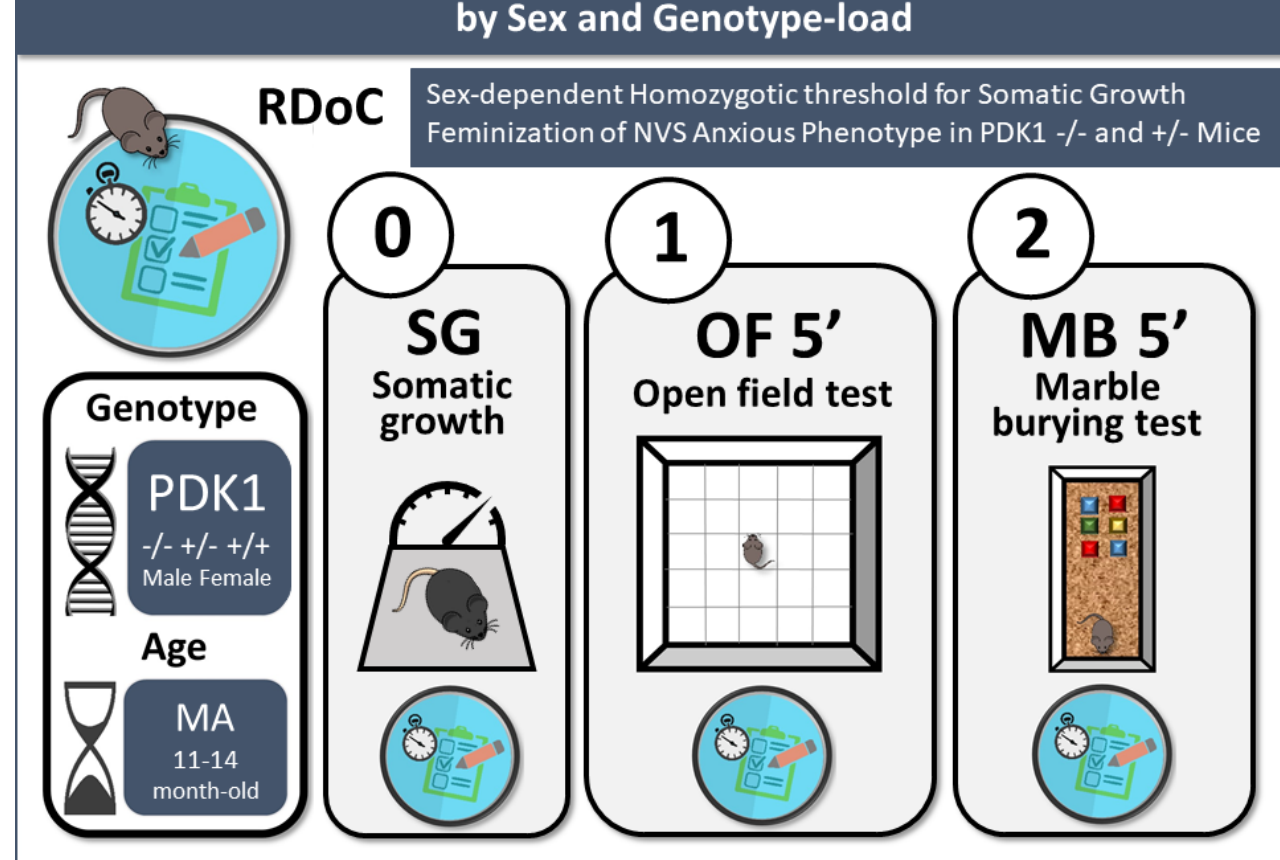
Figure 1. Graphical abstract. Fine-tuning the PI3K/Akt signaling pathway by sex and genotype-load. Experimental design: 3-days battery to assess somatic growth and the Research Domain Criteria (RDoC) negative valence system (NVS) in male and female PDK1 − / − , PDK1+/ − and PDK1+/+ mice at mature age (MA) are illustrated. Main findings are also indicated.